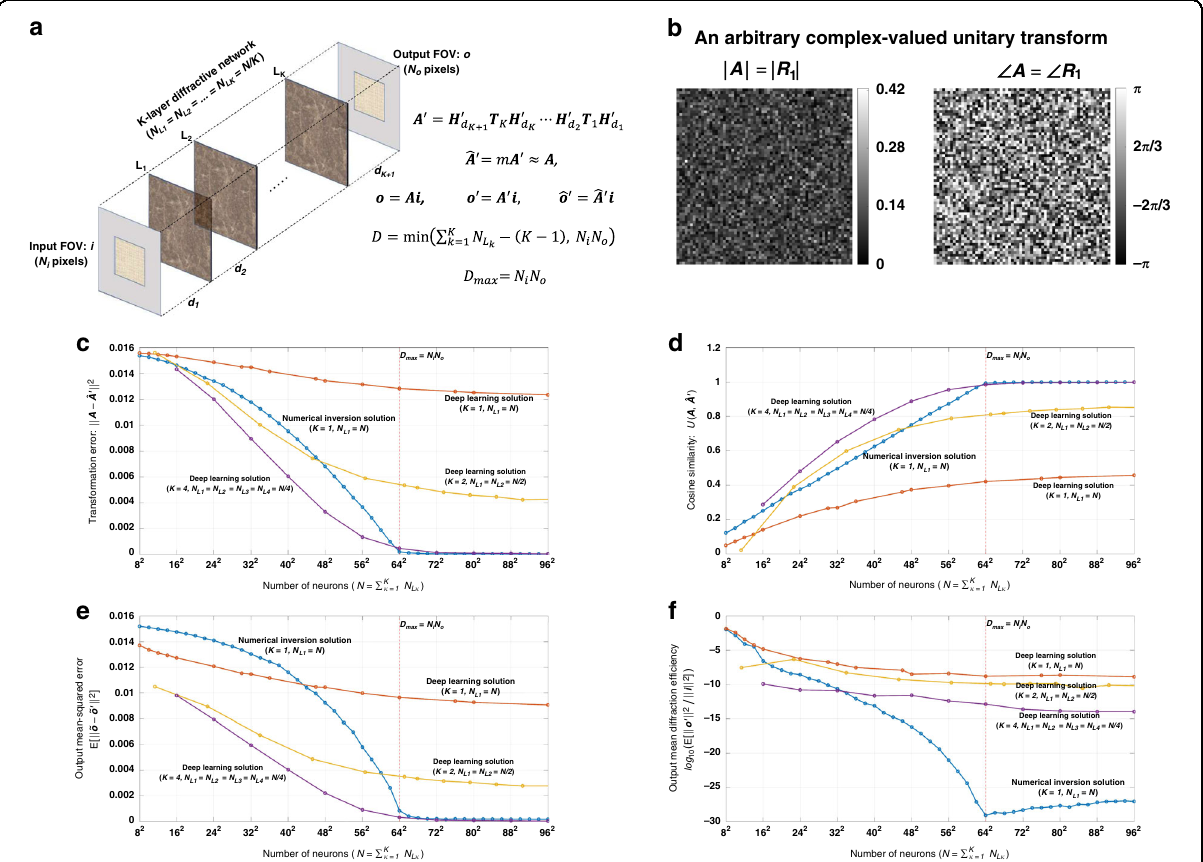
Fig. 1 Diffractive all-optical transformation results for an arbitrary complex-valued unitary transform. a Schematic of a K-layer diffractive network, that all-optically performs a linear transformation between the input and output fi elds-of-views that have N i and N o pixels, respectively. The all-optical transformation matrix due to the diffractive layer(s) is given by A ′ . b . The magnitude and phase of the ground truth (target) input-output transformation matrix, which is an arbitrarily generated complex-valued unitary transform, i.e., R H (see Eq. 5). The x -axis of the fi gure shows the total number of neurons ( N ) in a K-layered diffractive network, where each diffractive layer includes N / K neurons. Therefore, for each point on the x-axis, the comparison among different diffractive designs (colored curves) is fair as each diffractive design has the same total number of neurons available. The simulation data points are shown with dots and the space between the dots are linearly interpolated. d Cosine similarity between the vectorized form of the target transformation matrix in ( b ) and the resulting all-optical transforms (see Eq. 16). e Output MSE between the ground-truth output fi elds and the estimated output fi elds by the diffractive network (see Eq. 18). f The diffraction ef fi ciency of the designed diffractive networks (see Eq.